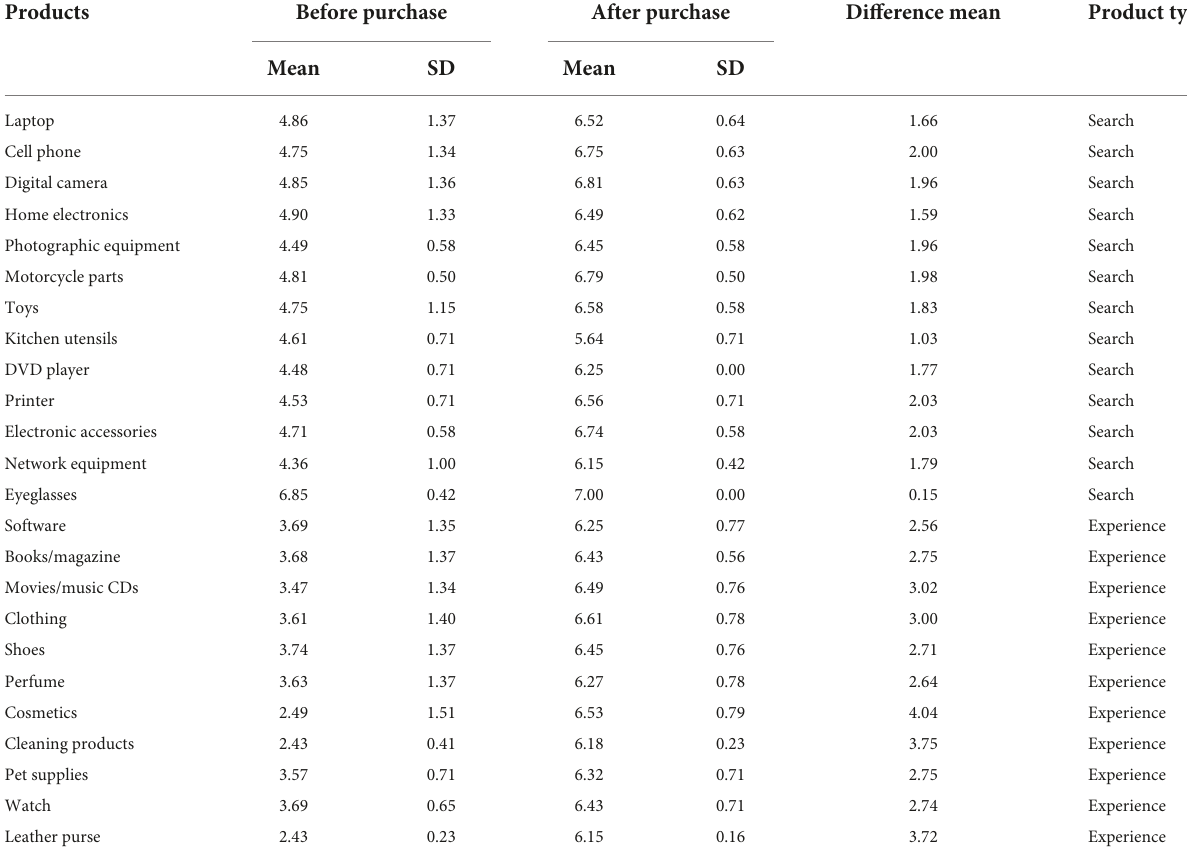
TABLE 3 Respondents’ ability to judge the performance of products before and after purchase.